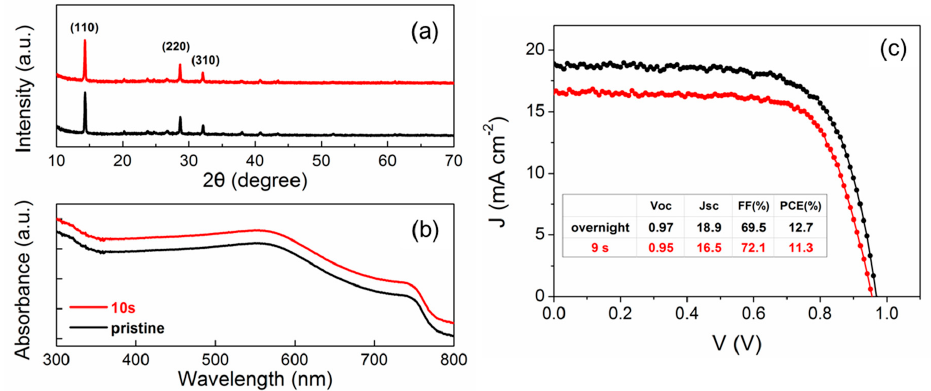
Figure 5. ( a ) XRD patterns of the perovskite films as-prepared in N 2 -filled glovebox (black) and exposed to O 2 / Ar plasma for 10 s (red); ( b ) UV-vis absorbance spectra of the perovskite films as-prepared in N 2 -filled glovebox (black) and exposed to O 2 / Ar plasma for 10 s (red); ( c ) Current density-Voltage characteristics of perovskite solar cells stored in dry air overnight (12 h) and exposed to O 2 / Ar plasma for 9